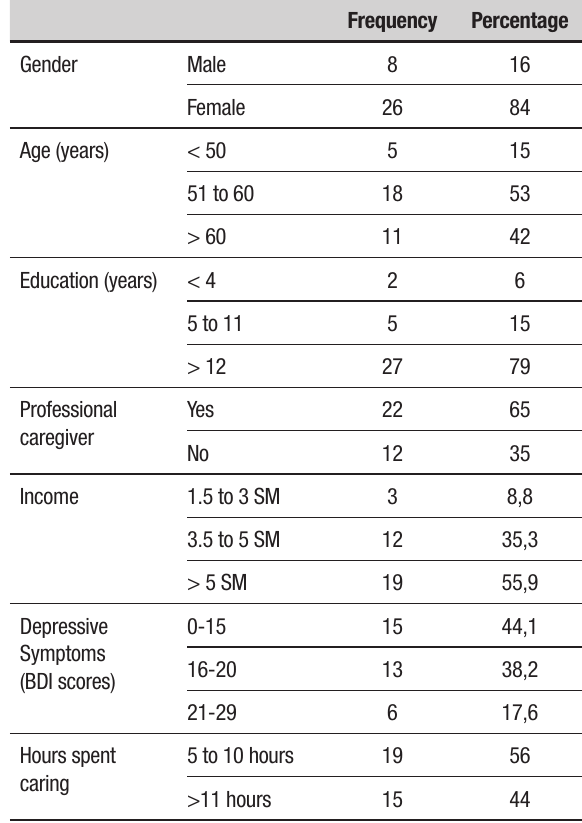
Table 1. Sociodemographic characteristics of caregivers of patients with Alzheimer’s